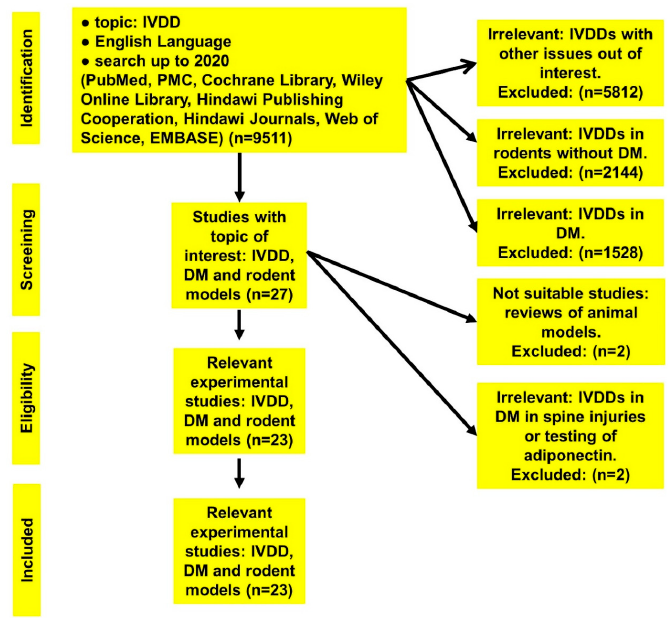
Figure 2. Flowchart of the search strategy and screening process. DM: diabetes mellitus, IVDD: intervertebral disc degeneration.